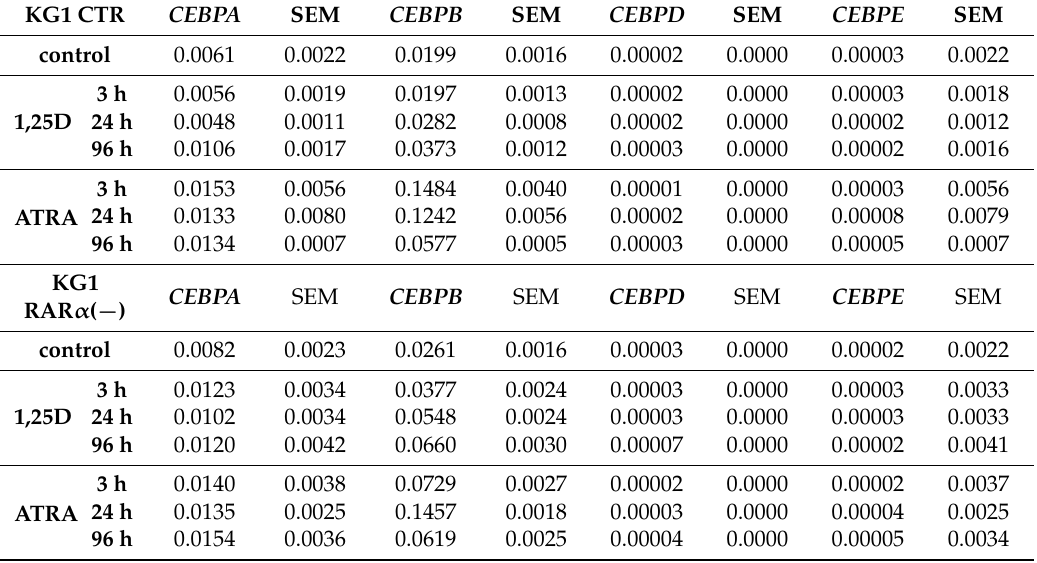
Table A3. Comparative quantification of CEBP genes related to a reference GAPDH gene in KG1-CTR and KG1-RAR α ( − ) cells.